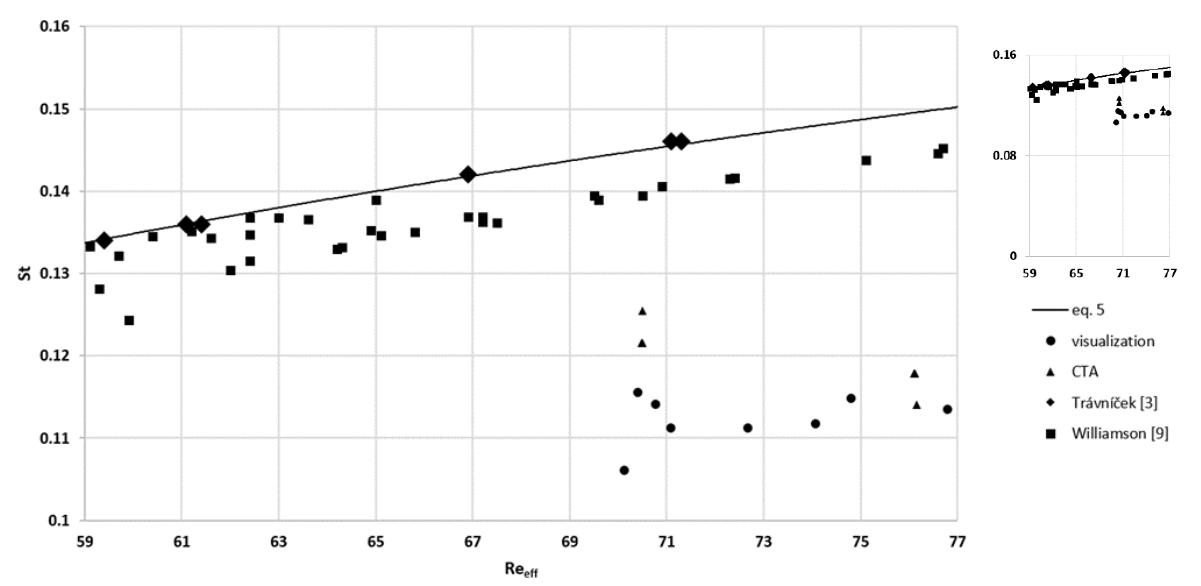
Fig. 9 Dependence of the Strouhal number St on the effective Reynolds number Re eff